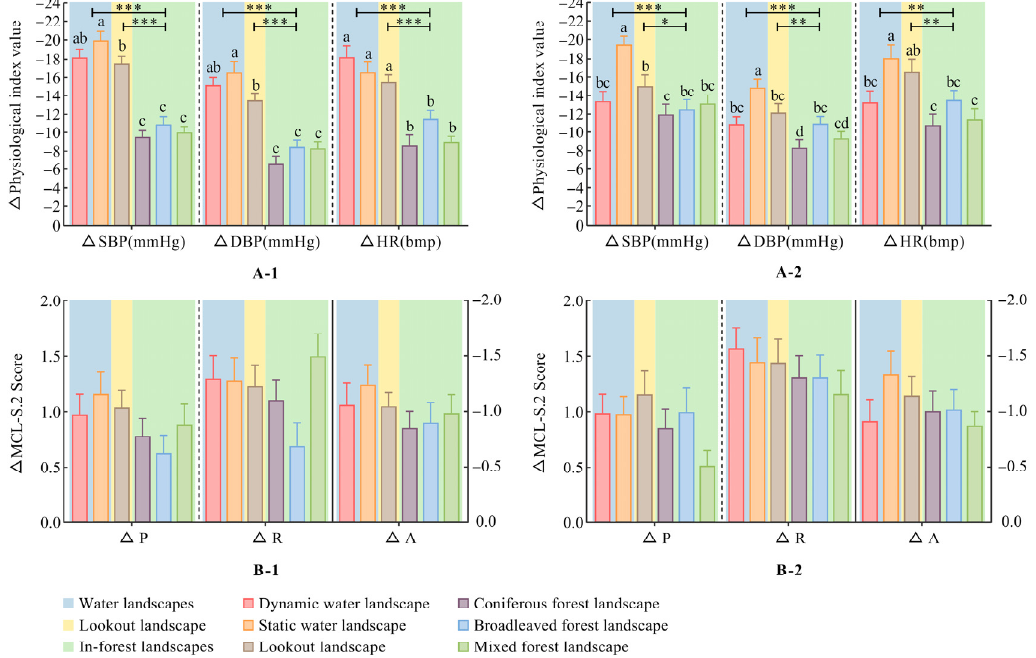
Figure 3. Comparison of the changes in physiological and psychological indexes of recreation spaces in the same season. ( A-1 ) Spring physiological indexes. ( A-2 ) Autumn physiological indexes. ( B-1 ) Spring psychological indexes. ( B-2 ) Autumn psychological indexes. Mean ± SE; “*”: significant differences among the three landscape types, * p < 0.05, ** p < 0.01, *** p < 0.001; “Lowercase letters”: significant differences ( p < 0.05) among the six spaces; one-way ANOVA. △ D = post–pre. SBP: systolic blood pressure; DBP: diastolic blood pressure; HR: heart rate; P: pleasantness; R: relaxation; A: anxiety. This figure was created by Rui Chen.